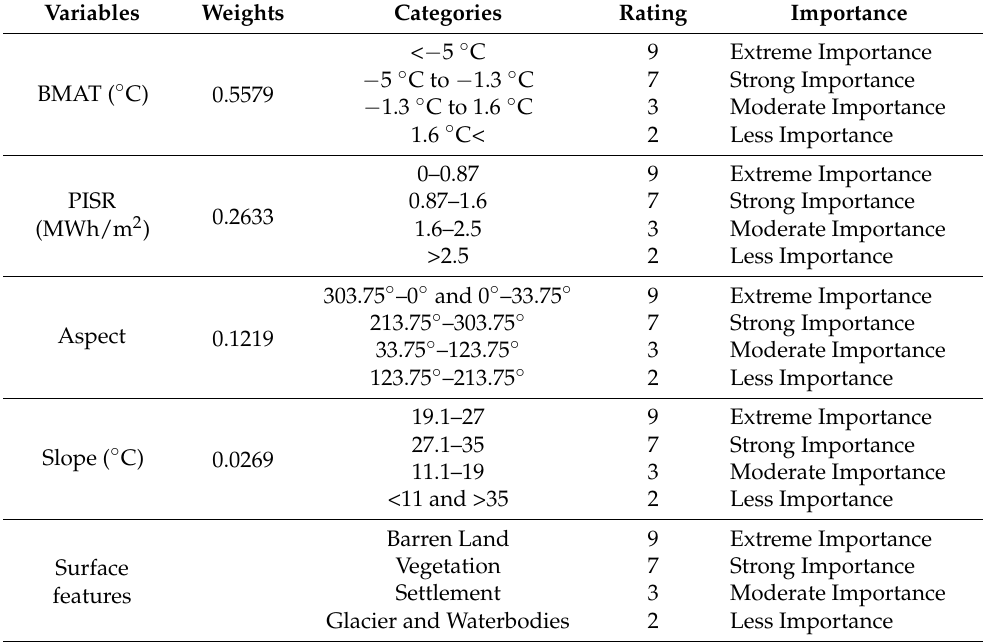
Table 3. Weights and ratings of permafrost variables in the Analytical Hierarchy Process